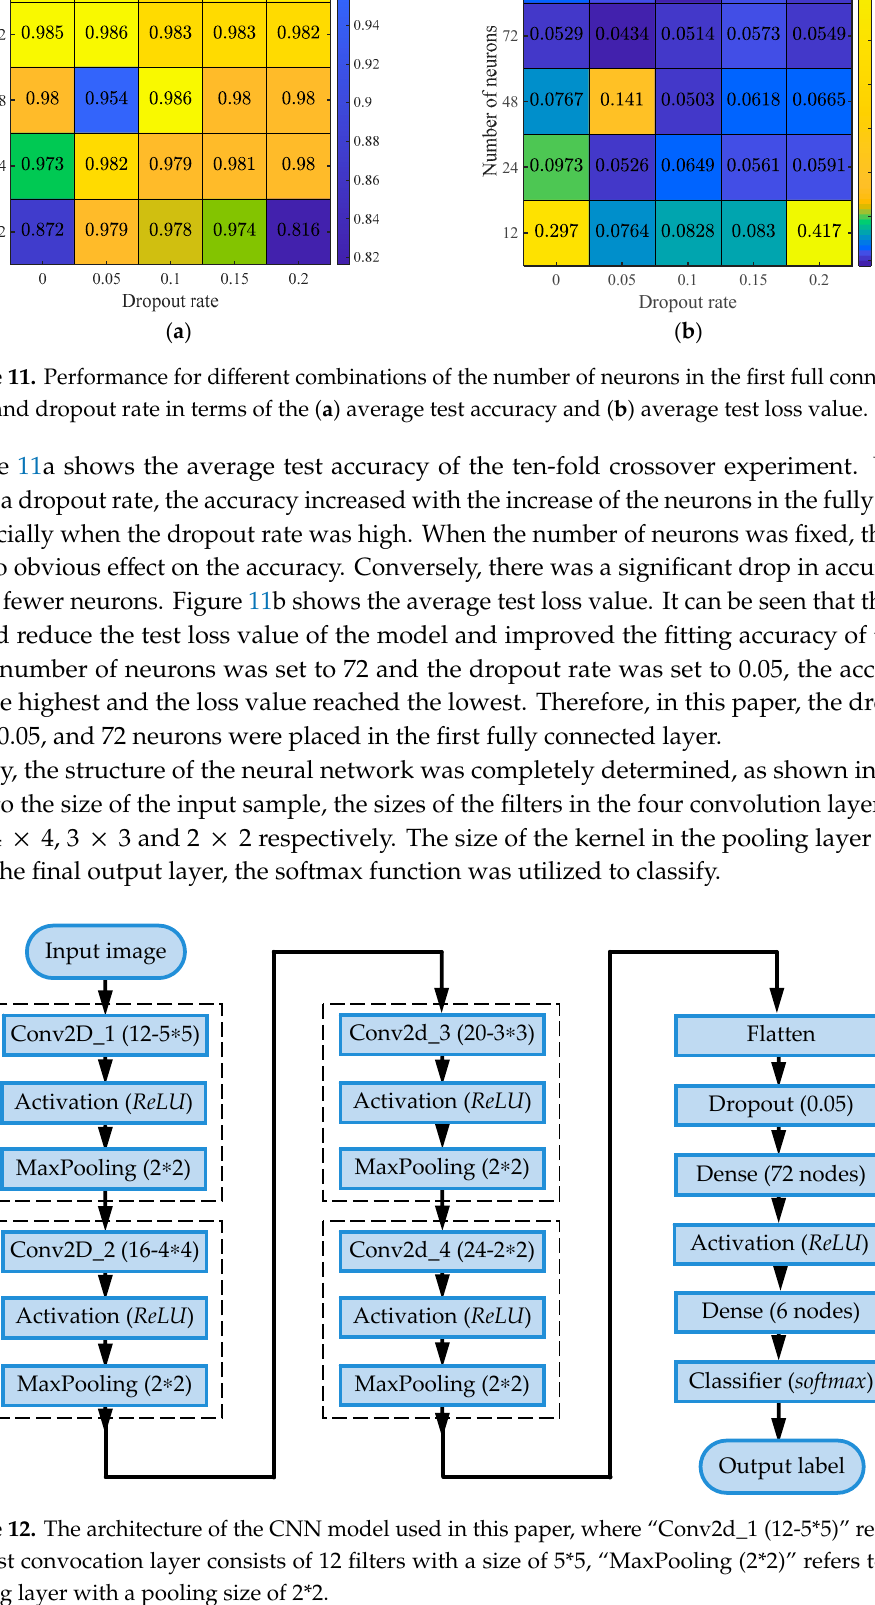
15 of 27 Figure 10. Training results of neural network models with different structures. The size of the input sample and the structure of the model determine the size of the feature